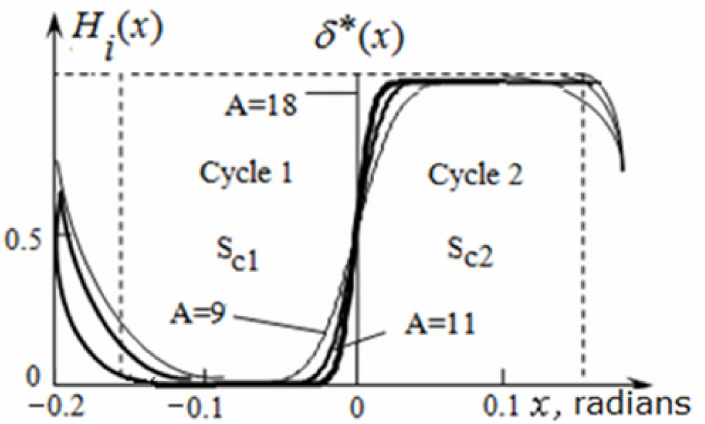
Figure 5. Representation of the effect of expanding the space–time to regulate the stability of processes with an increasing degree of combining